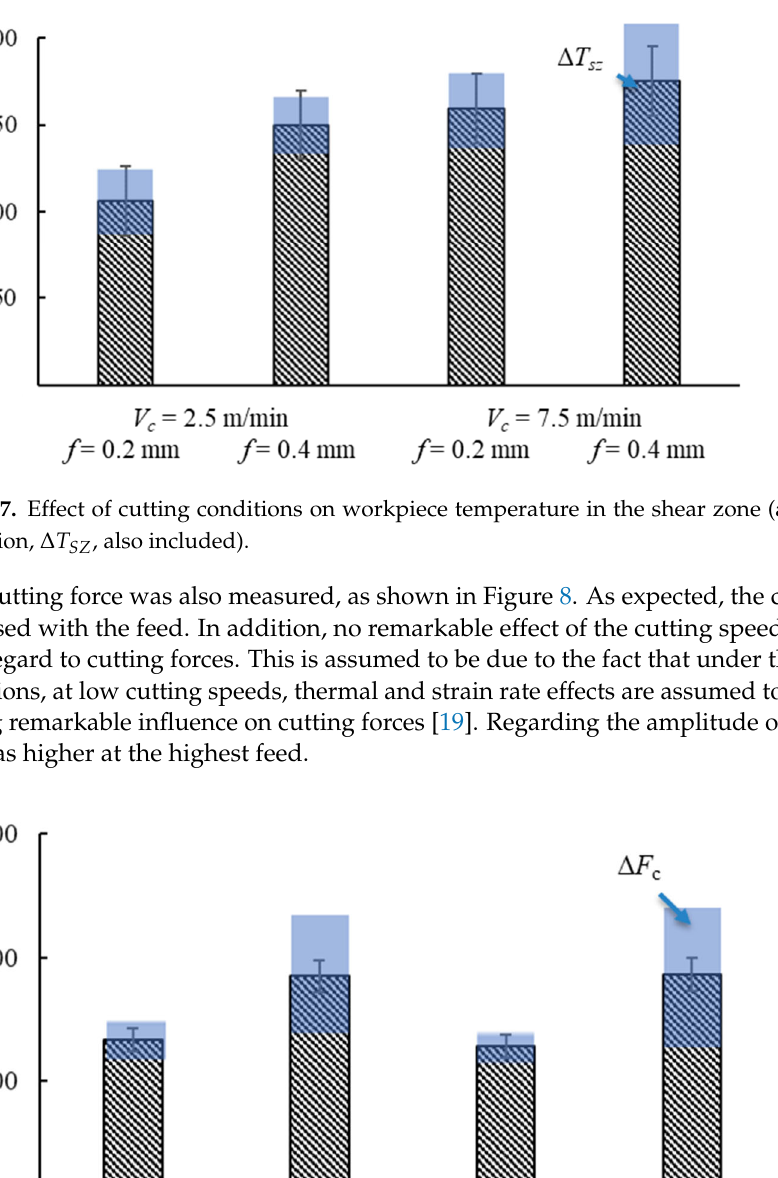
Figure 8. Effect of cutting conditions on cutting force (amplitude of oscillation, ∆𝐹 (cid:3030) , also included).